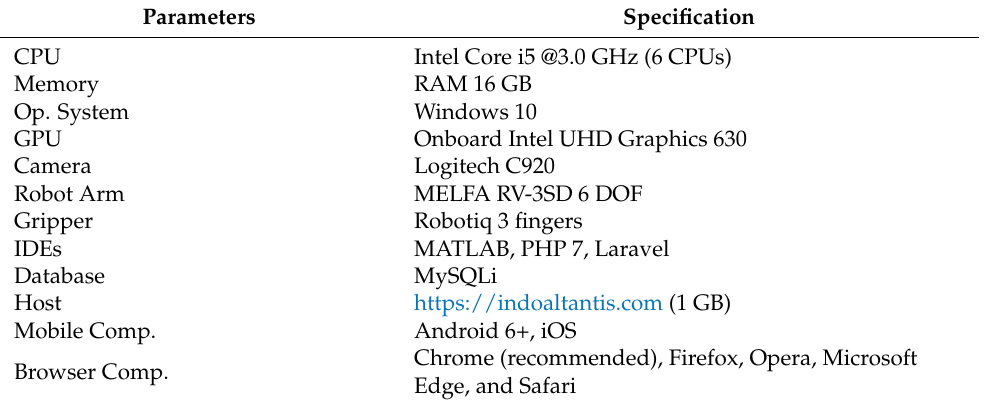
Table 2. The minimum settings of our system.